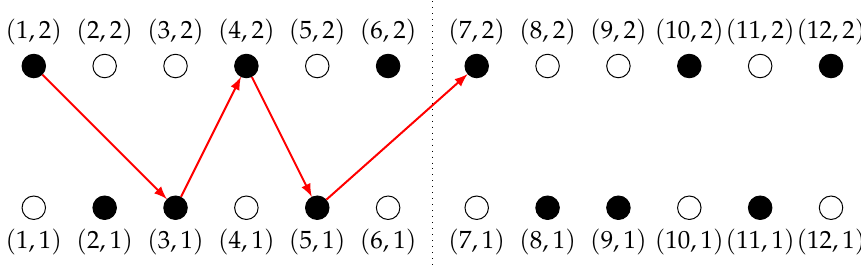
Figure 3. An example of a highlighted path (marked in red) for CAP instance with n = 6 and m = 2; the path corresponds to P = ( 2,1,1,2,1,2 )